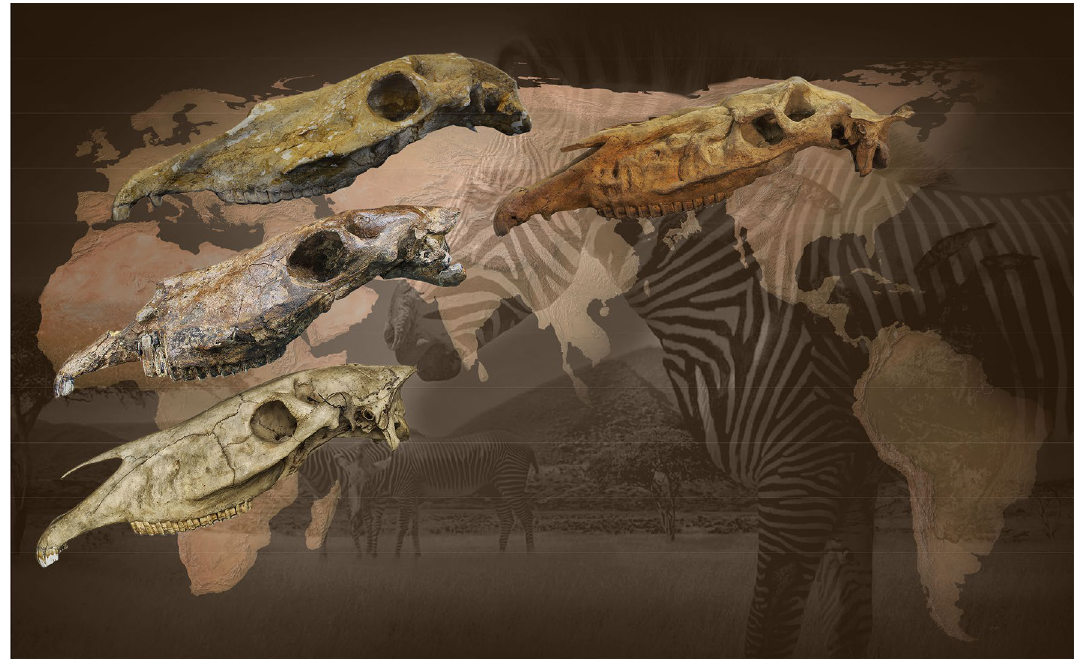
Figure 6. Evolutionary framework of the extant zebras Equus grevyi since the oldest common ancestor Equus simplicidens , and through the European Equus stenonis and the African Equus koobiforensis . The present figure aims to represent the dispersal of the genus Equus in the Old World by E. simplicidens at the beginning of the Pleistocene, and the origin of the extant zebras E. grevyi through the E. stenonis and E. koobiforensis lineage. Artwork O. Cirilli (map edited from row data of QGIS v.3.18.1 (https:// www. qgis. org/ it/ site/), zebras in background edited from Nina Marie Photography (https:// ninam ariev isuals.